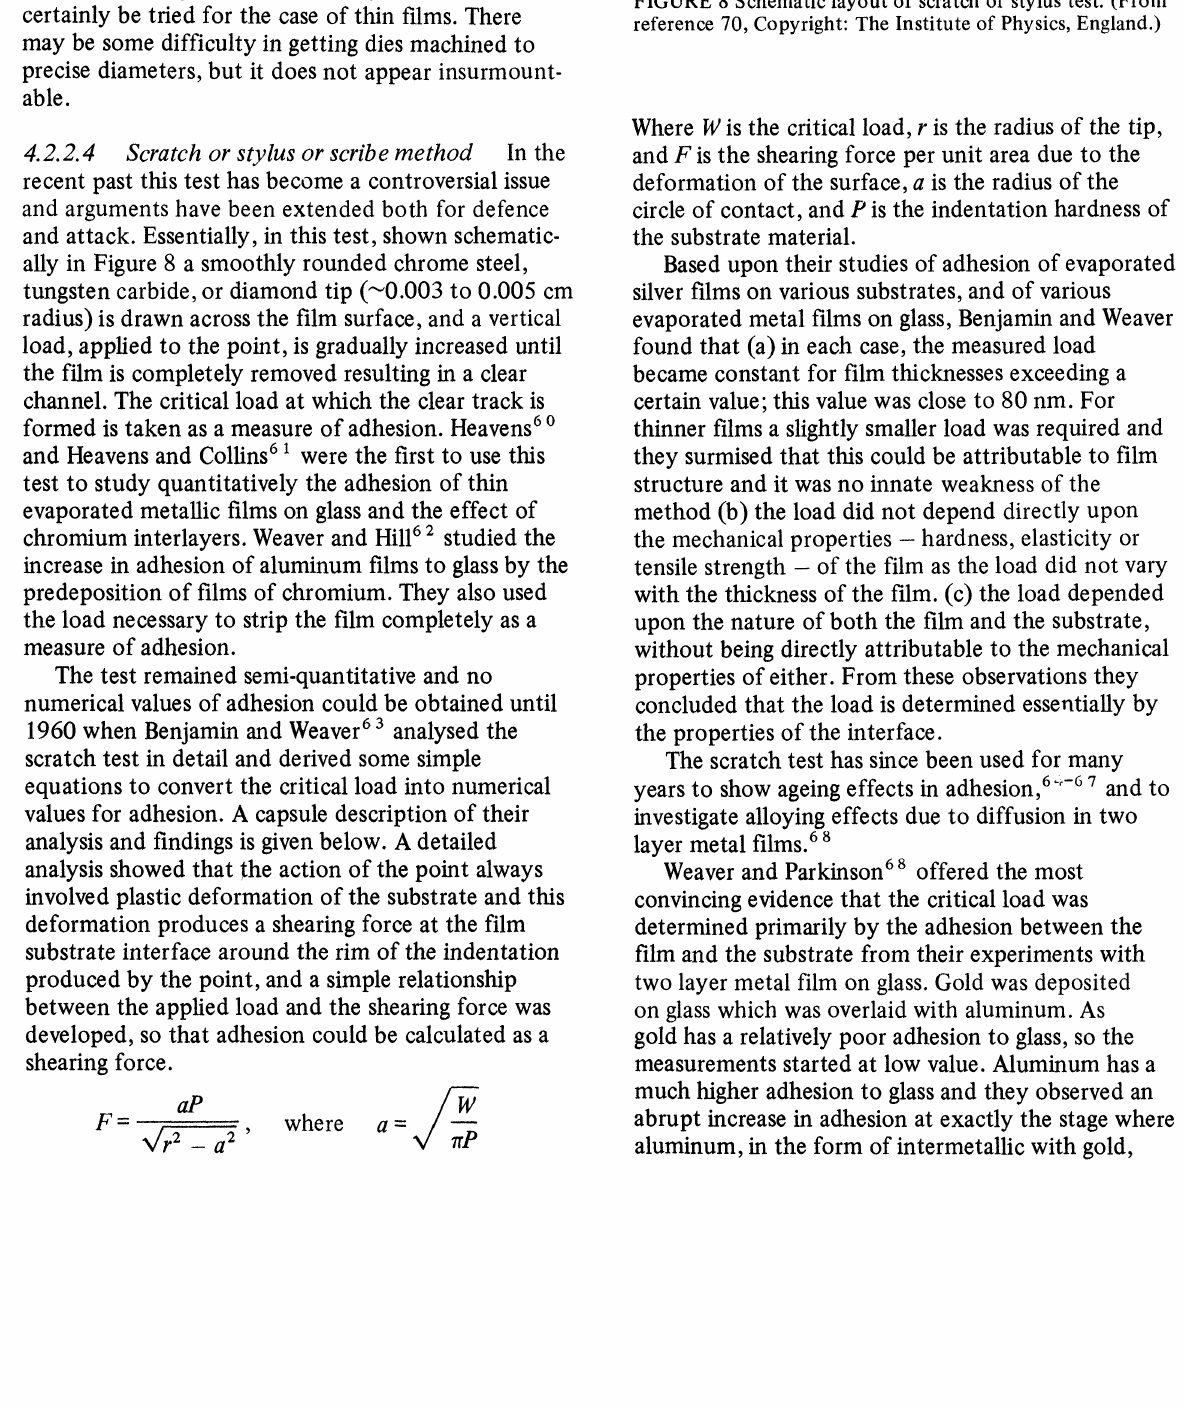
FIGURE 8 Schematic layout of scratch or stylus test. (From reference 70, Copyright: The Institute of Physics,